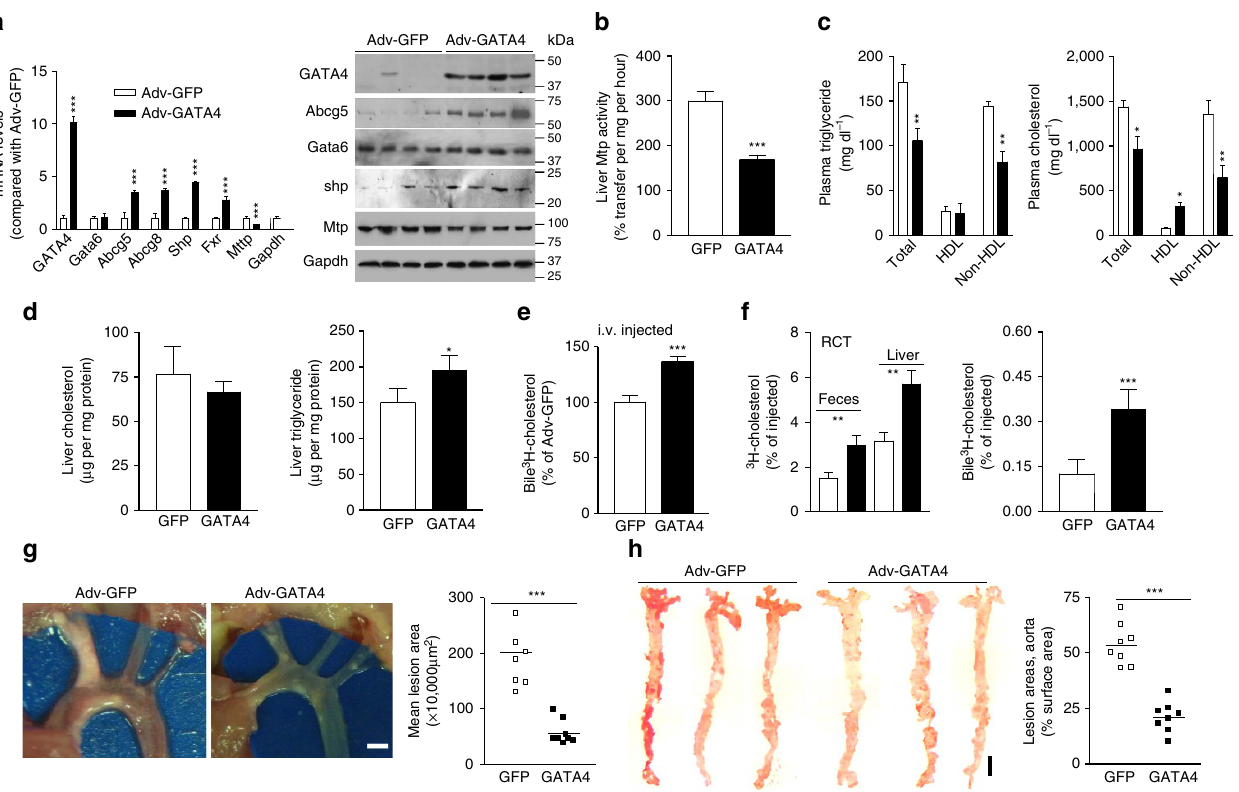
Figure 8 | Effects of hepatic GATA4 expression in L-Bmal1 (cid:2) / (cid:2) Apoe (cid:2) / (cid:2) mice. L-Bmal1 (cid:2) / (cid:2) Apoe (cid:2) / (cid:2) mice ( n ¼ 8, each group) were transduced with (1.5 (cid:3) 10 11 p.f.u.) Adv-GFP (white square) or Adv-GATA4 (black square) and started on a Western diet. After 4 weeks, plasma and liver were collected for different analysis. ( a ) mRNA and protein levels of indicated proteins in the liver. ( b ) Hepatic MTP activity was measured in mice transduced with different viruses. ( c ) Triglyceride and cholesterol in total plasma, HDL and non-HDL. ( d ) Liver cholesterol and triglyceride were quantified. ( e ) Amount of 3 H- cholesterol excreted into the bile after intravenous injections. ( f ) Amounts of cholesterol found in the bile, feces and liver 48h after the placement of 3 H- cholesterol-loaded macrophages in the peritoneum during RCT. ( g ) Atherosclerotic plaques in the aortic branches were exposed, photographed (left) and lesion areas were quantified (right). Scale bar, 2mm. ( h ) Aortas were stained for lipids and lesion areas were quantified. Scale bar, 5mm. Data in a – f were evaluated using the unpaired Student’s t -test. Data in g and h were analysed by one-way ANOVA. Values are mean ± s.d., n ¼ 8 per group. * P o